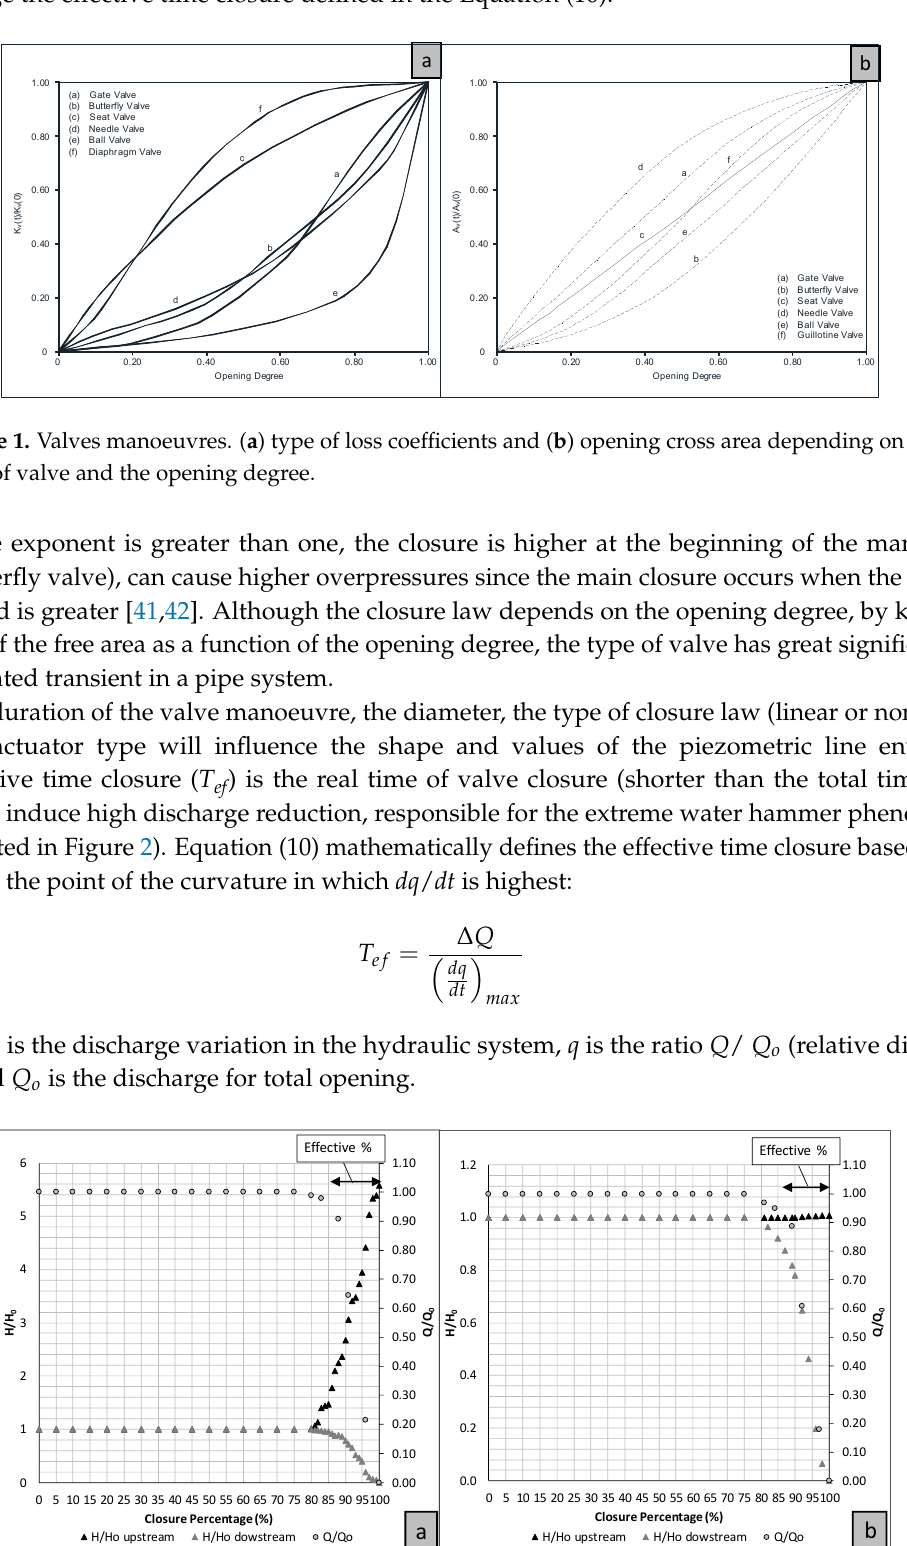
Figure 2. Comparison between effective closure and total closure of a ball valve: H / H 0 (upstream and downstream) variation and 𝑄 / 𝑄 0 . ( a ) turbulent flow (Re = 100,000) and ( b ) laminar flow (Re = 1000).